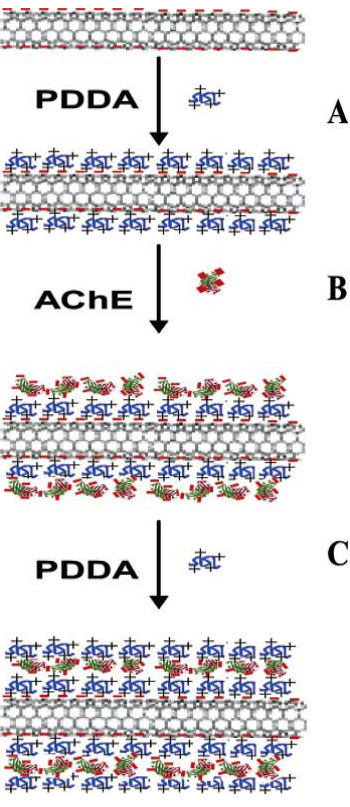
Figure 1. Schematic representation of layer-by-layer electrostatic self-assembly of AChE on MWCNTs: (A) assembling positively charged PDDA on negatively charged MWCNT (B) assembling negatively charged AChE (C) assembling the second PDDA layer (reproduced with permission from Liu et al.